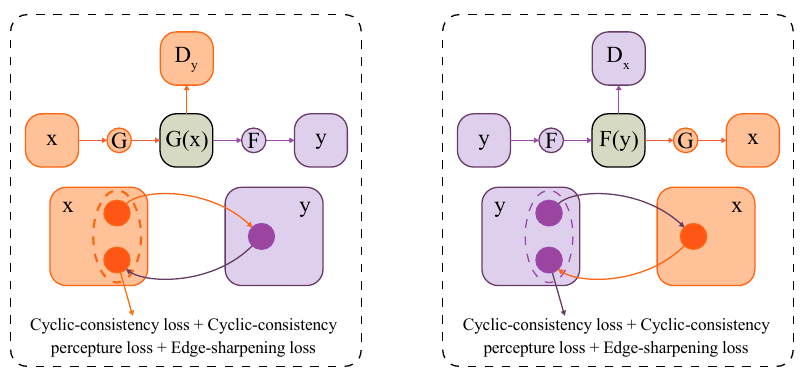
Figure 4. Process of the loss function.